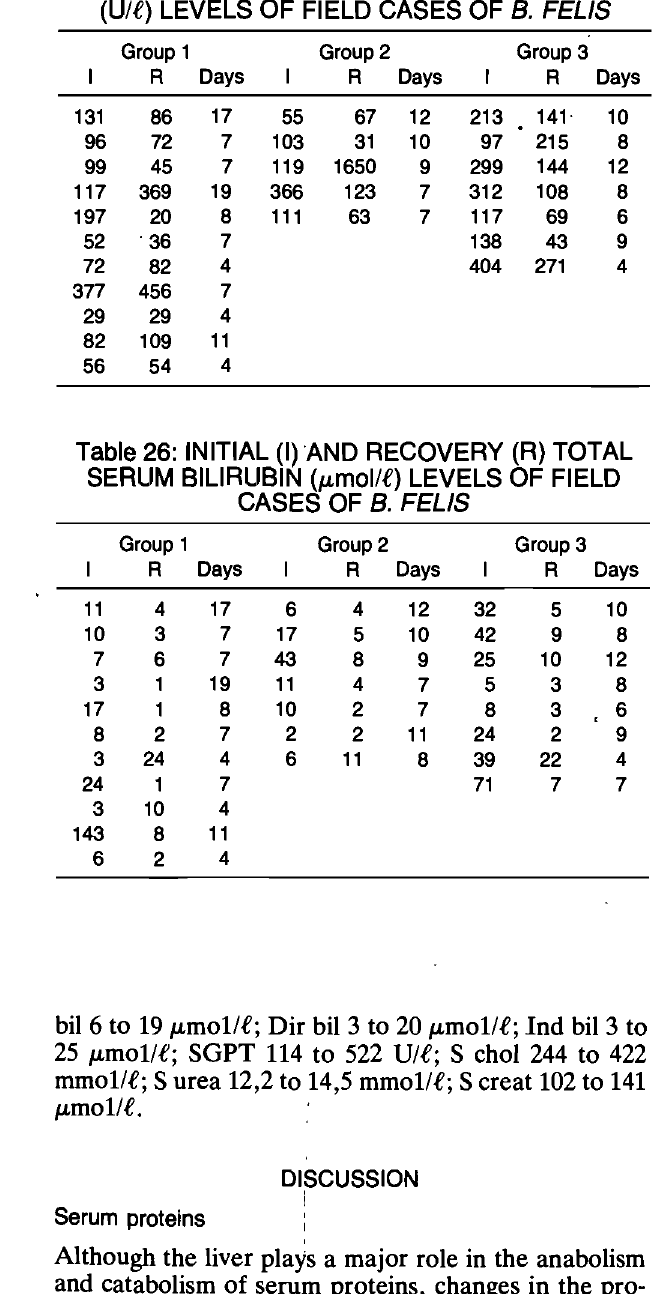
Table 26: INITIAL (I) AND RECOVERY (R) TOTAL SERUM BILIRUBIN (JLmol/e) LEVELS OF FIELD CASES OF B.